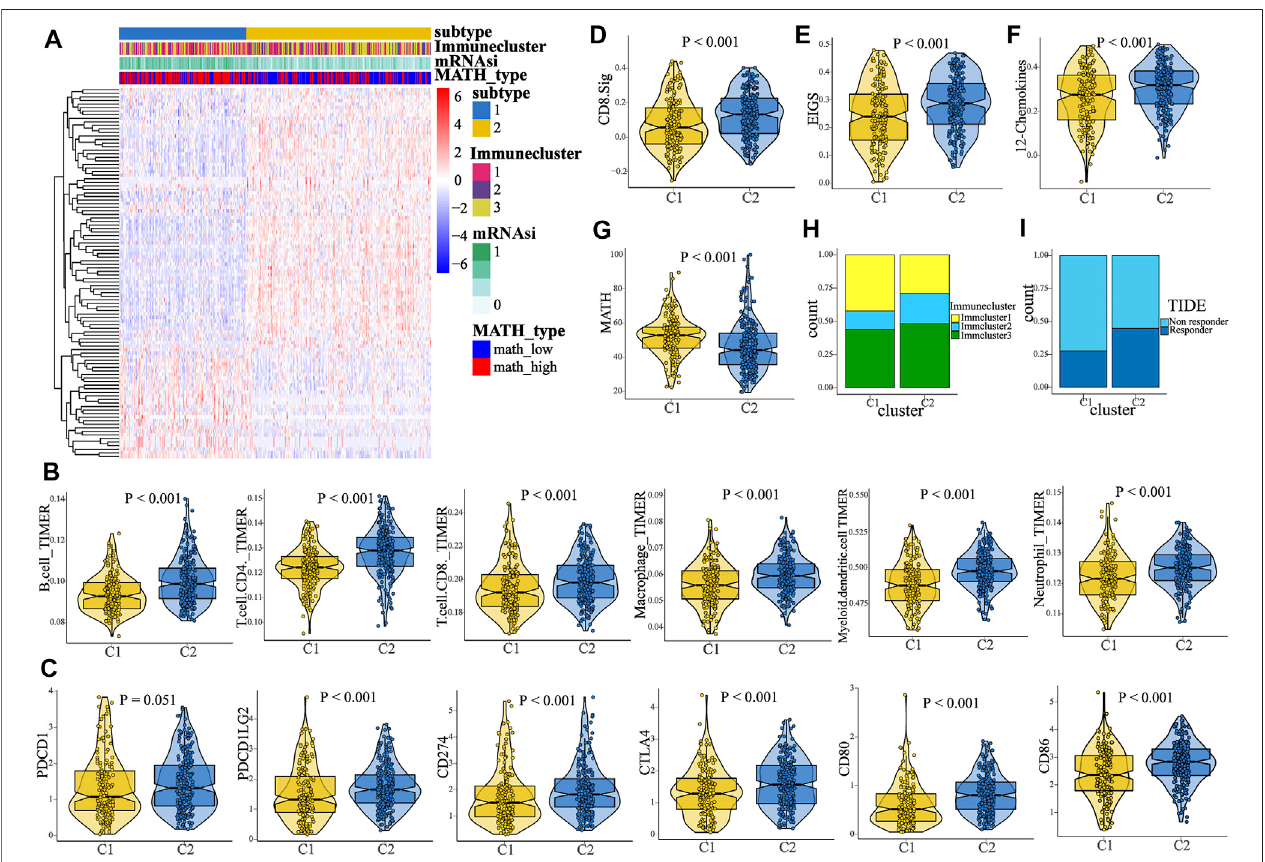
FIGURE 5 | Identi fi cation of two MATH-based clusters with distinct characteristics and survival outcome. (A) Heat map showed the result of the unsupervised consensus clustering based on the 104 DEGs, and two clusters were identi fi ed. (B) Comparison of the abundance of B cell, CD4 T cell, CD8 T cell, macrophage, dendritic cell, and neutrophil between C1 and C2. (C) Comparison of the expression level of PD-1/PD-L1/PD-L2/CTLA-4/CD80/CD86 between C1 and C2. (D – F) Comparison oftheenrichmentlevelofthree immunotherapy-related signaturesbetweenC1and C2,including CD8. sig,EIGS (expanded immune genesignature), and12chemokinessig. (G) PatientsinC1hadahigherMATHscorethanpatientsinC2. (H) DistinctproportionsofdifferentimmuneclustersinC1andC2,indicatingthe different immunity between the two subtypes. (I) . TIDE algorithm predicted the likelihood of response to immunotherapy in C1 and C2.